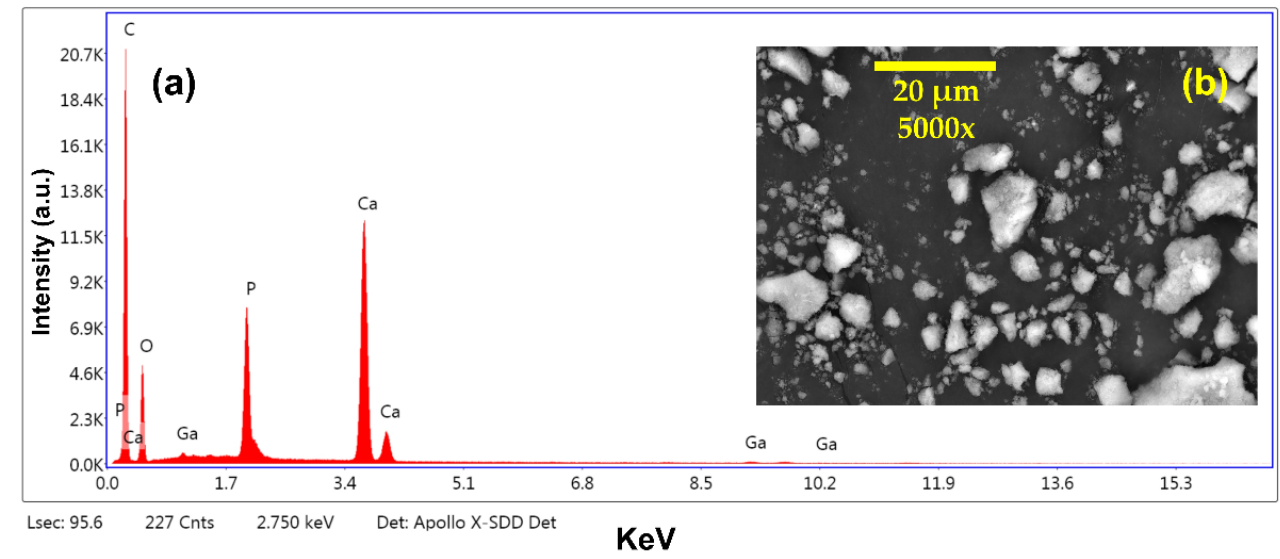
Figure 3. ( a ) EDS analysis of Ga-HA and ( b ) FESEM micrographs of